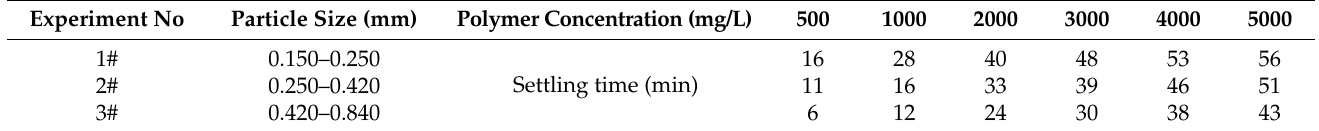
Table 4. Particle Suspension Data Sheet at Different Polymer Concentrations.